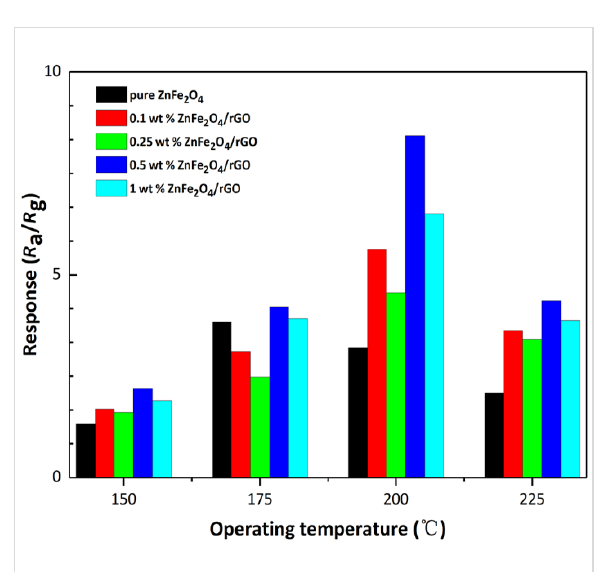
Figure 7: Response of the hollow spheres made of pure ZnFe 2 O 4 and the four different ZnFe 2 O 4 /rGO composites used as gas sensors to 10 ppm acetone vapor at 150–225